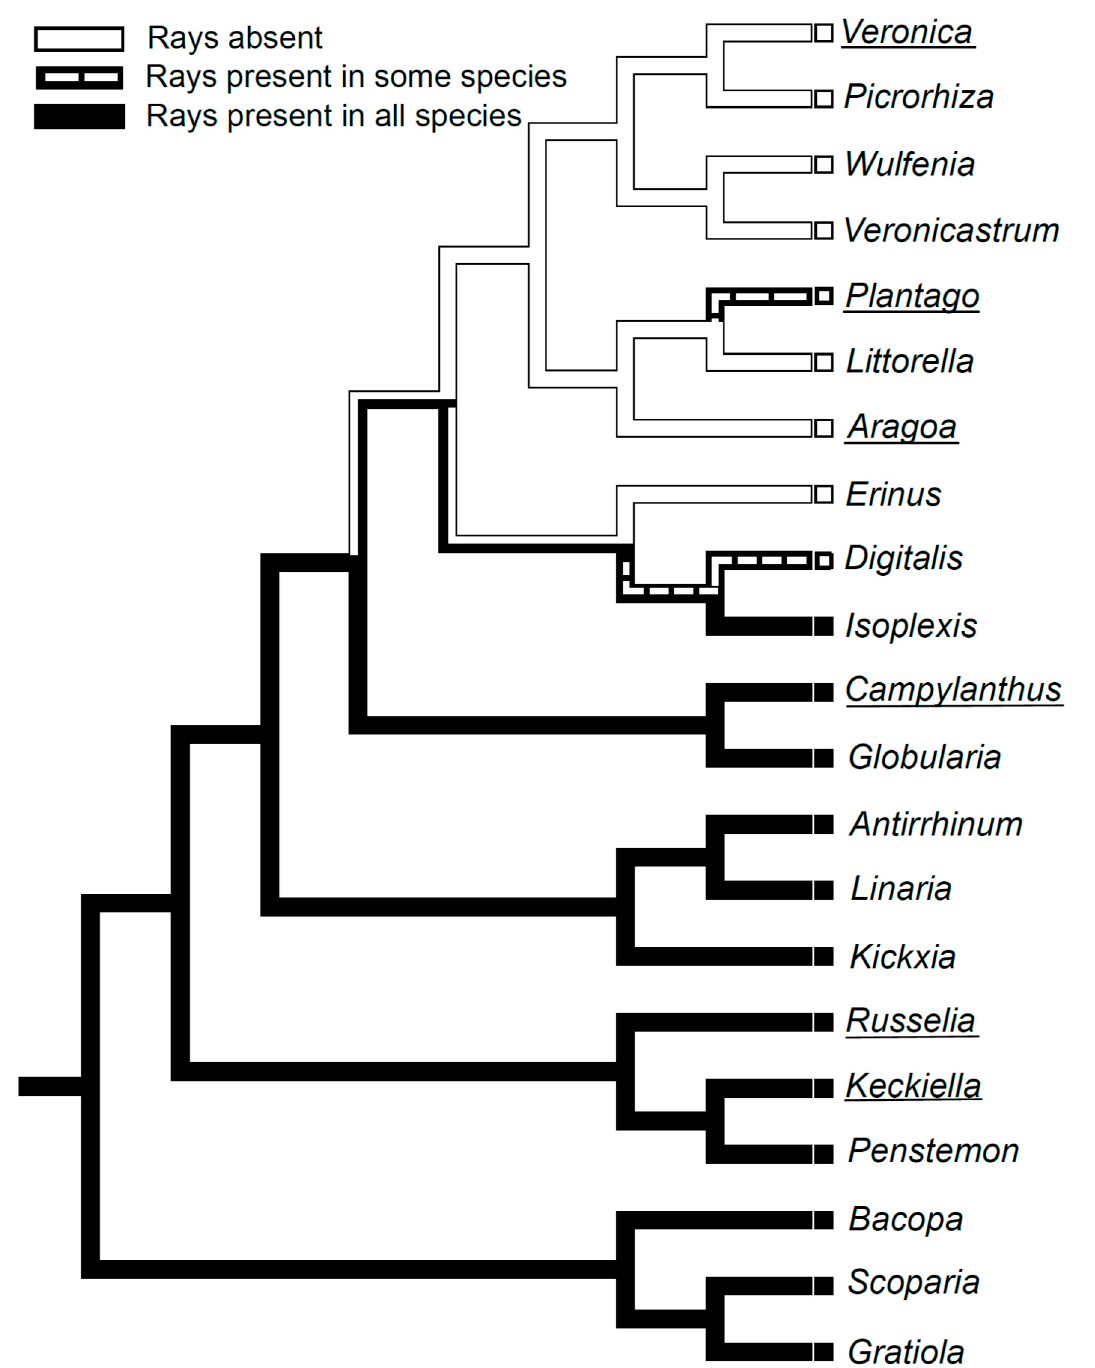
Figure 5. Distribution of the presence or absence of rays in the wood mapped onto a subsample of the most parsimonious tree of the combined analysis of one nuclear and three plastid regions for the family Plantaginaceae [8]. The genus Littorella was added to this tree following [9]. The names of genera containing shrubby species are underlined; other genera are herbaceous.